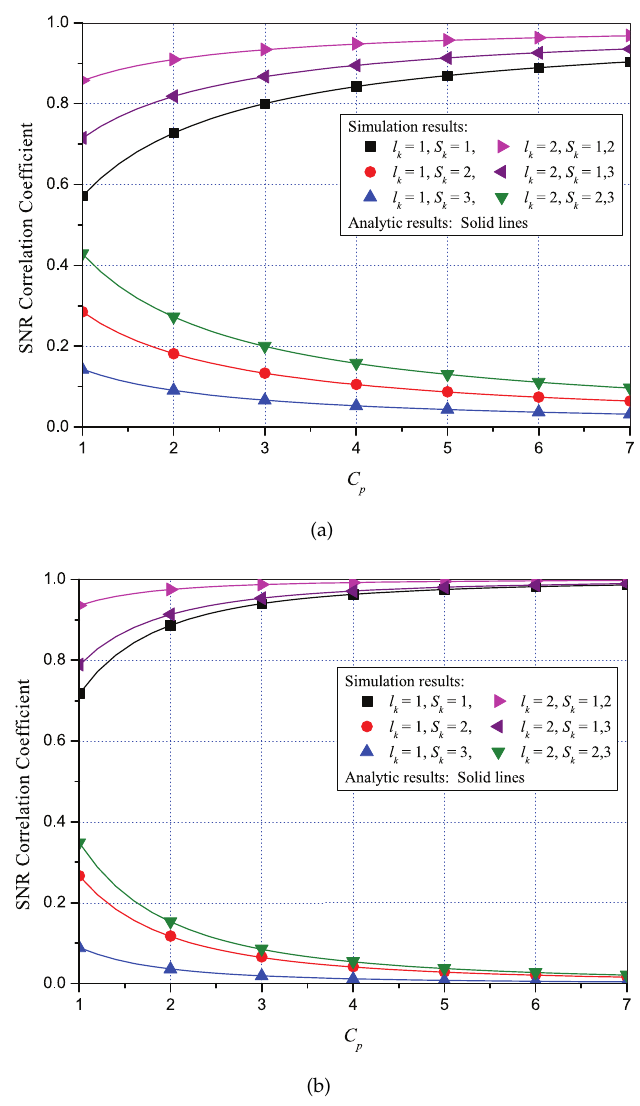
Figure 2. SNR correlation coefficient for N k = 3 for all k when K = 2 and R t = 1 bps/Hz: = 22 dB and m ( a ) P k , n / σ 2 k , n and n